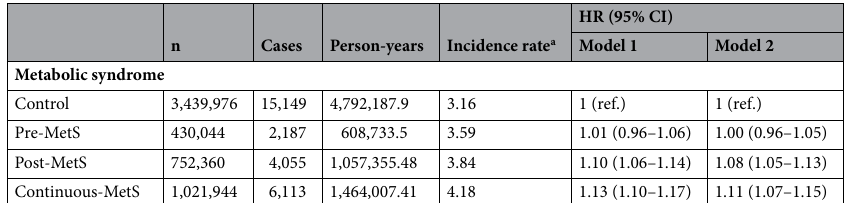
Table 2. Multivariable HRs of psoriasis risk according to MetS diagnosis changes (CI, confidence interval; HR, hazard ratio). Values are expressed as HRs (95% CIs) based on Cox proportional hazard regression analysis. Model 1: adjusted for age and sex. Model 2: adjusted for age, sex, smoking, alcohol consumption statuses, physical activity, and BMI. a per 1,000 person-years. BMI, body mass index; CI, confidence interval; HR, hazard ratio; MetS, metabolic